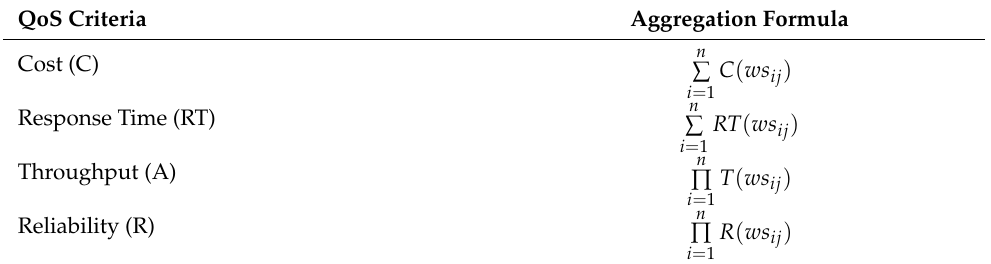
Figure 1. The WSC problem representative model. Table 1. The QoS values aggregation